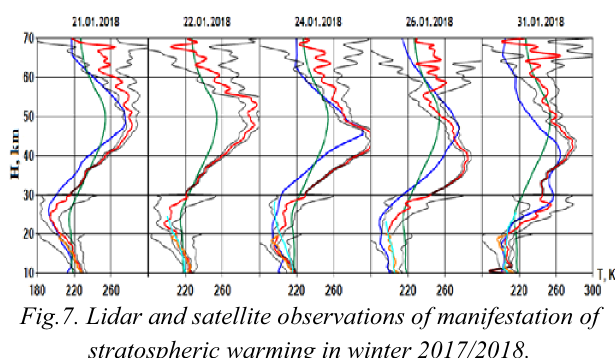
Fig.7. Lidar and satellite observations of manifestation of stratospheric warming in winter